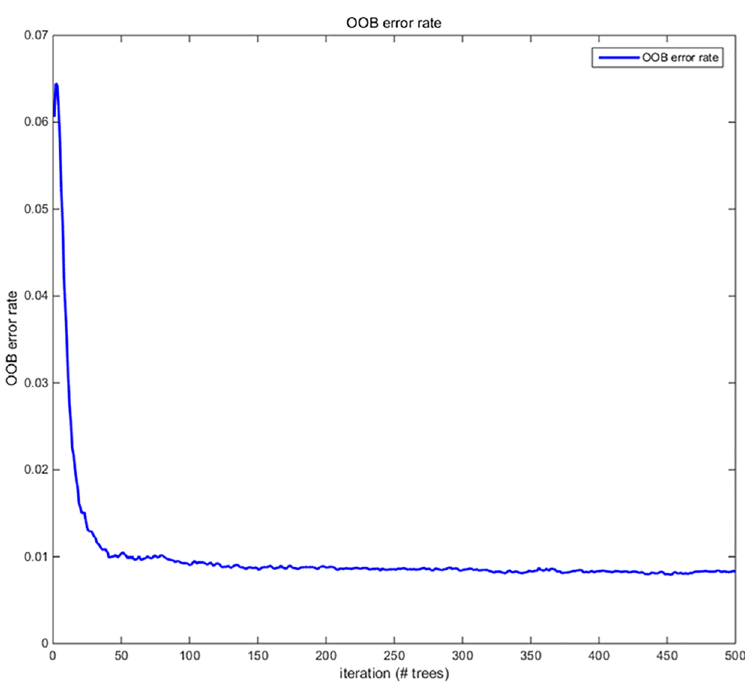
Fig 9. Number of decision trees and OOB error rate curve. Fig 9 shows that the classification error rate decreases with an increasein the number of decisiontrees. After reachingthe 100 trees, the classification error trends to be stable (approximately